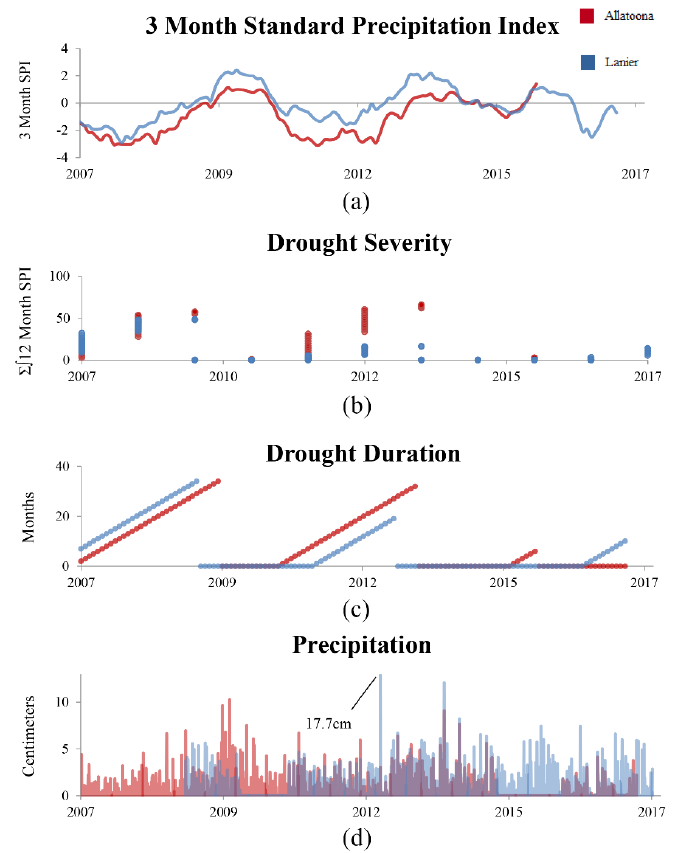
Figure 8. Hydrologic and meteorologic trends for Lake Allatoona and Lake Lanier during the study period. ( a ) The three-month Standard Precipitation Index (SPI); ( b ) Drought severity calculated from the 12-month SPI; ( c ) Drought duration in months since the beginning of a drought period; ( d ) Precipitation values, showing a few extremely large rainstorms. The two reservoirs share a climate region, but Lake Allatoona has experienced more prolonged and extreme drought in the last